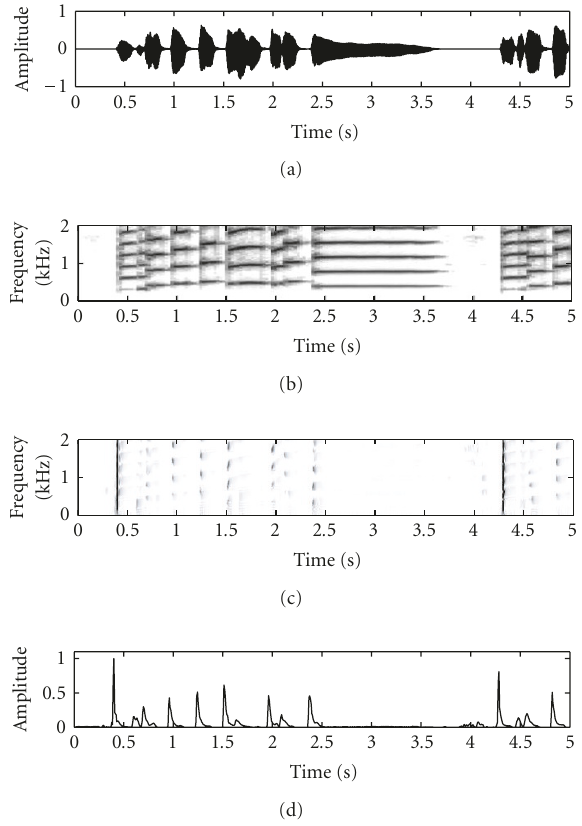
Figure 5: Trumpet signal example (a)–(d): harmonic part wave- form, spectrogram representation, the corresponding spectral flux E ( l , k ), and the detection function v ( l